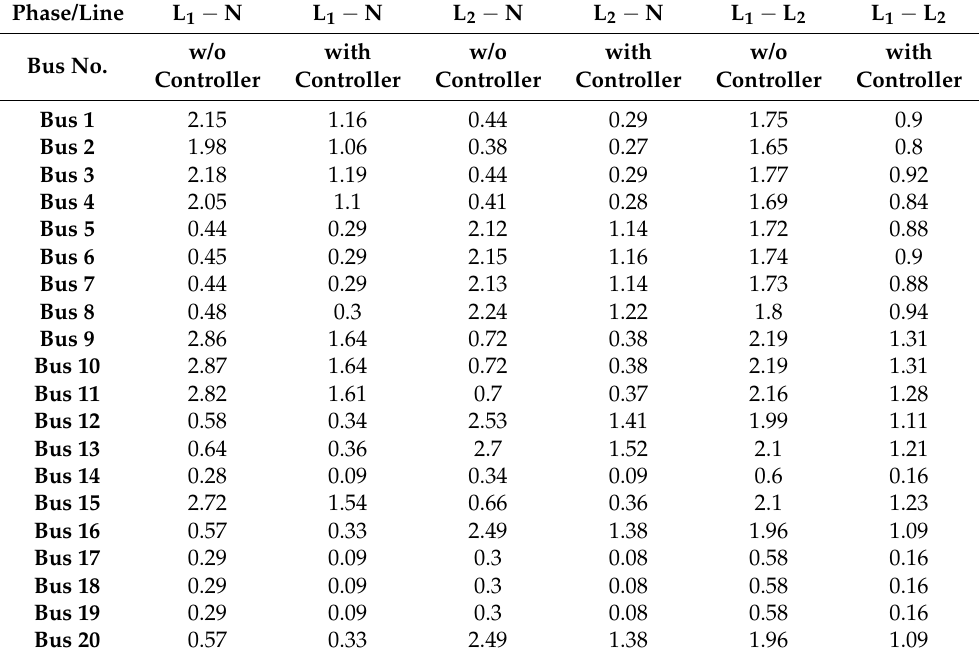
Figure 9. Phase voltages in scenario 1, ( a ) at bus 10 with EV charging between phase L 1 bus 15 with no EV present at it; ( c ) at bus 8 with EV charging between phase L 2 with EV charging between phase L 2 Table 3. Root mean square deviation in voltages in scenario 1 with and without the proposed